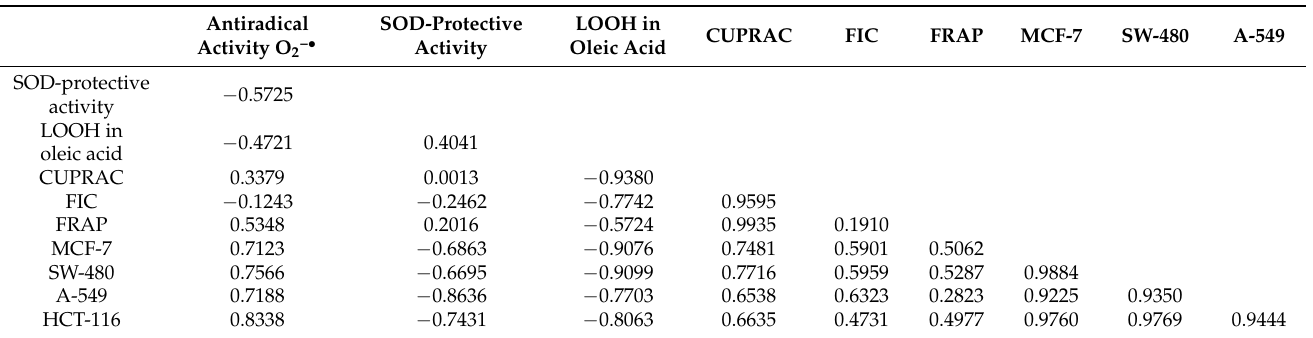
Table 5. Pearson’s correlation coefficient between the values of the parameters of antioxidant and cytotoxic activity on various model systems in